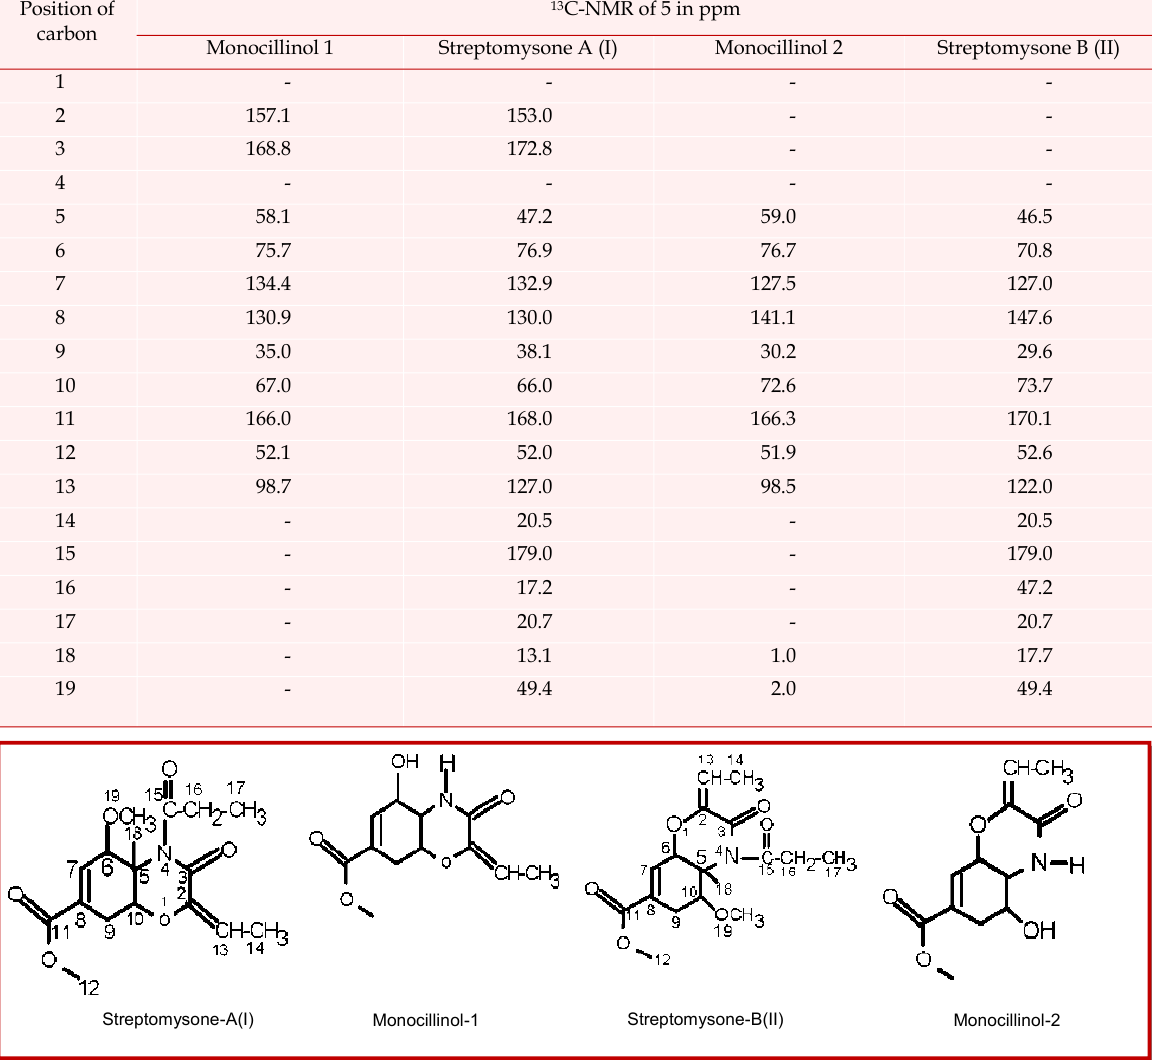
1 H-NMR and 13 C-NMR spectral data (500 MHz, CDCl 3 ) for compound I and II CDCl 3 ) for compound I and II Position of